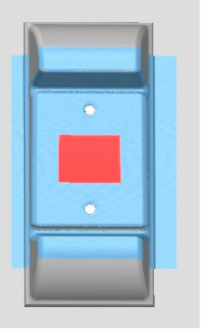
Figure 12. Result of the cropped supporting block plane fitting